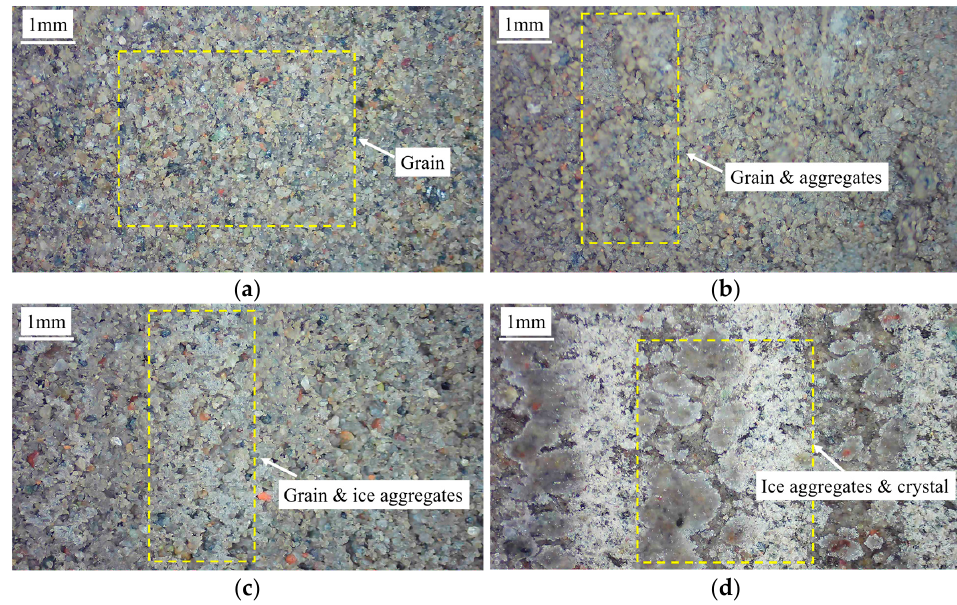
Figure 12. Surface images of the cement-treated sand specimens before and after testing. ( a ) Before testing; ( b ) after testing at 25 °C; ( c ) after testing at − 1 °C; ( d ) after testing at − 10 °C. Table 5. Parameters η 1 , η 2 , η 3 , and η 4 under different temperatures and the number of cycles. The relationship between τ f (kPa) of cold frozen cement-treated sand, T (°C), and σ N (kPa) is the same as Equation (8). The parameters η 1 , η 2 , η 3 , and η 4 are shown in Table 5. Temperature/ ◦ C Warm frozen cement-treated